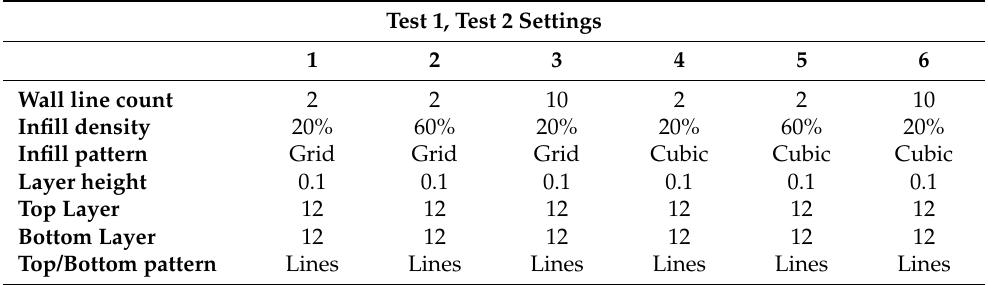
Table 6. Punch settings of Test 1 and Test 2.